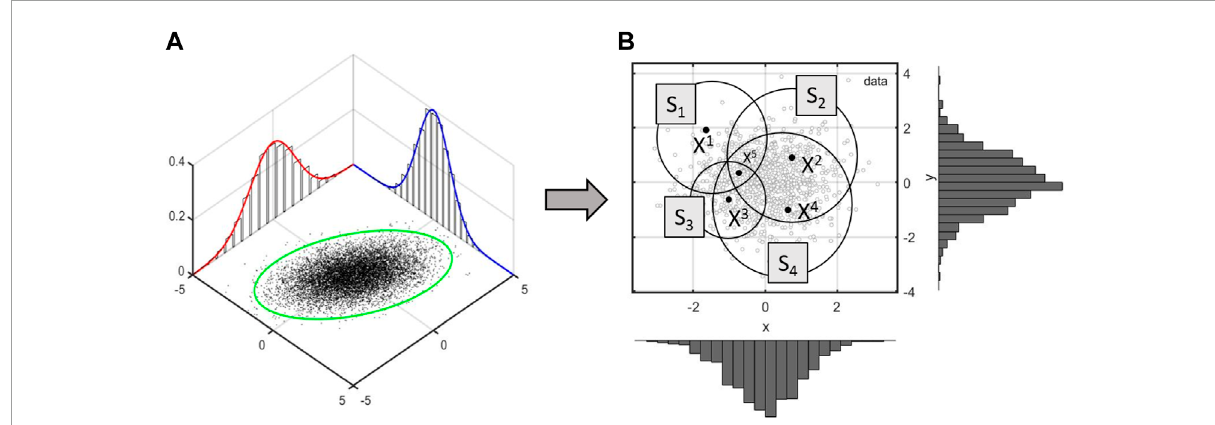
FIGURE 2 Illustration of the process to construct a measure matrix, like A in Eq. 3 . In (A) , a bivariate distribution space is displayed corresponding to a model with two parameters for simplicity. In the case of inputs, the dots on the surface represent the co-variance of points the investigator is able to run. The borders show each parameter’s individual distribution. In (B) , circles S j (hyper-spheres in higher dimensions) are drawn over the space to populate the measure matrix.